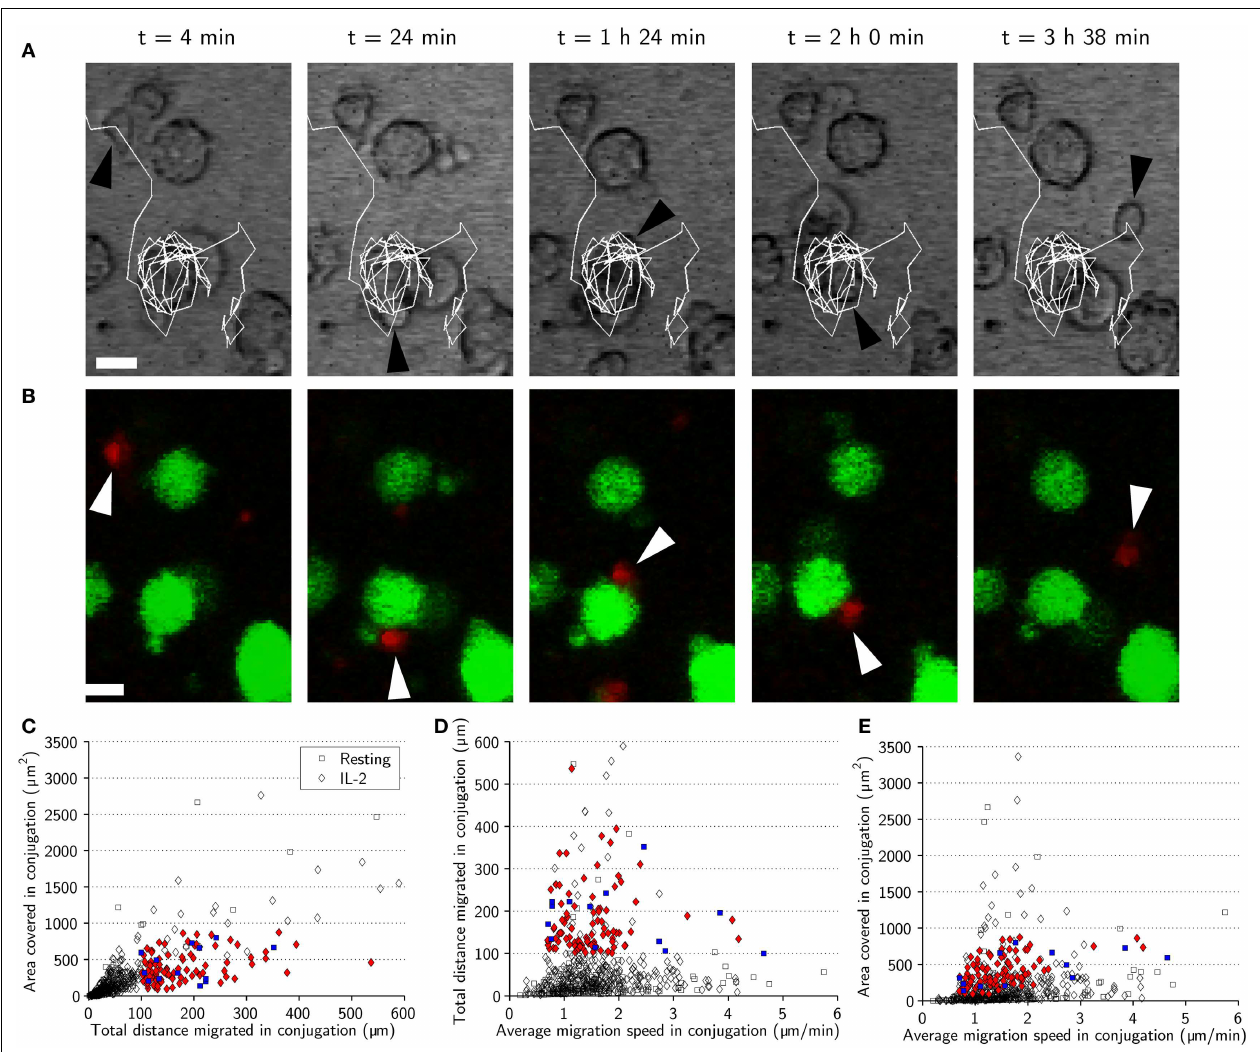
distance migrated in conjugation plotted vs. area covered in conjugation for resting (squares) and activated (diamonds) NK cells indicating the conjugation periods fulfilling the three criteria (blue squares and red diamonds for resting and activated NK cells, respectively). (D) Average migration speed in conjugation plotted vs. total distance migrated in conjugation for resting (squares) and IL-2-activated (diamonds) indicating motile scanning behavior (colored symbols). (E) Average migration speed in conjugation plotted vs. area covered in conjugation indicating motile scanning behavior (colored